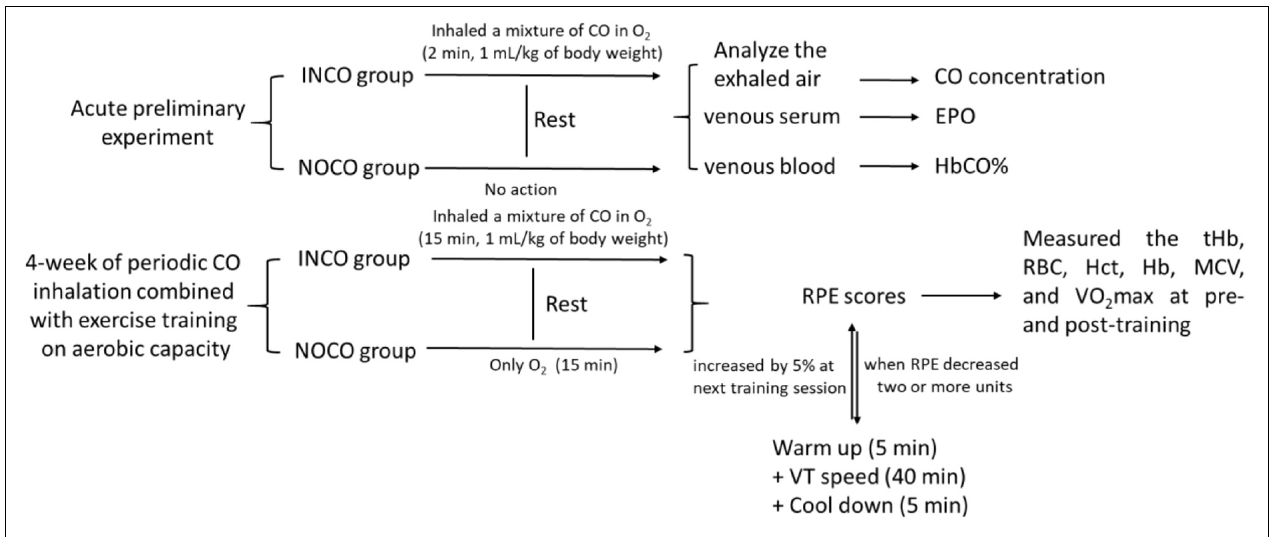
FIGURE 1 | The test protocol of study. The INCO, NOCO, VT, tHb, RBC, Hct, Hb, MCV, and RPE are training group with CO inhalation, control group with no CO inhalation, ventilatory threshold, total hemoglobin, red blood cells, hematocrit, hemoglobin, mean corpuscular volume, and ratings of perceived exertion, respectively.